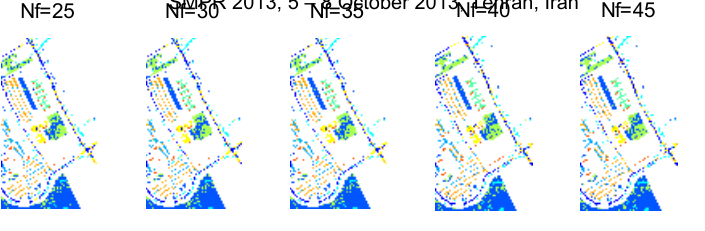
and different (cid:13) for Pavia university dataset 3 = 10 4